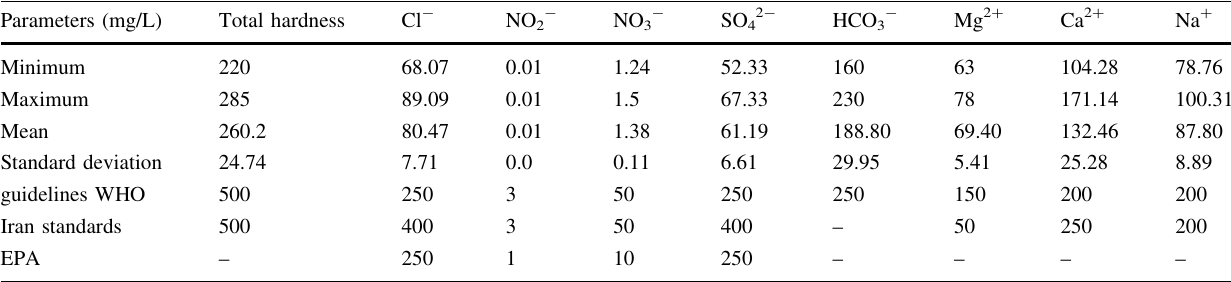
Table 4 Specifications on drinking water in Kerman in terms of various parameters, and in comparison with the national Iran standard, Environmental Protection Agency (EPA), and WHO